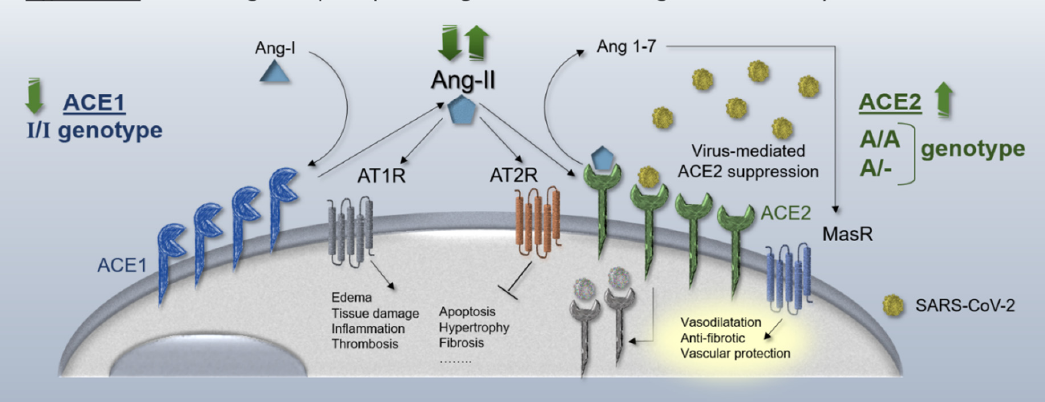
Figure 2. Hypothesized mechanisms of different genetic haplotypes in ACE1 and ACE2 genes in the RAS pathway. Upper panel, the ACE2 downregulation due to virus entry is exacerbated by “loss of function” ACE2 8790 G/G genotype (homozygous G/G females and hemizygous G/- males). The coexistence of ACE1 upregulation due to “gain of function” D/D genotype leads on unrestrained RAS deregulation and ARDS establishment. Lower panel, the ACE2 downregulation due to virus entry is weakened by “gain of function” ACE2 8790 A/A genotype (homozygous A/A females and hemizygous A/- males). The coexistence of ACE1 downregulation due to “loss of function” I/I genotype counteracts RAS unbalancing avoiding ARDS establishment.